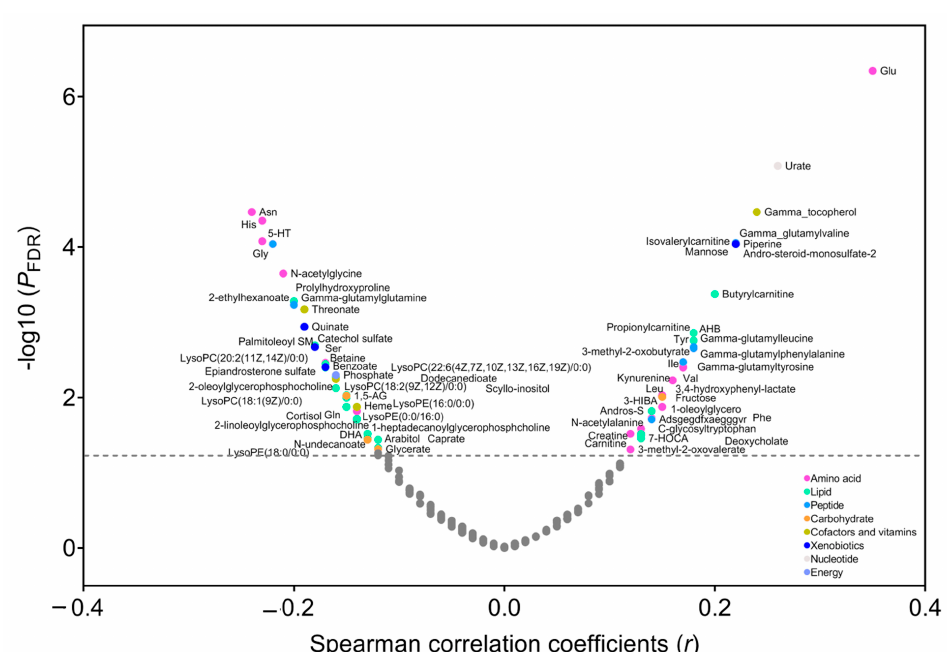
Figure 1. Correlation between metabolites and body mass index (BMI) in the PLCO. Spearman’s partial correlation was used to adjust for age, sex, smoking status, and pack-years of smoking. The metabolites above the horizontal line had a statistically significant correlation with BMI ( p FDR < 0.05). Abbreviations: PLCO, Prostate, Lung, Colorectal, and Ovarian Cancer Screening Trial; FDR, false discovery rate.